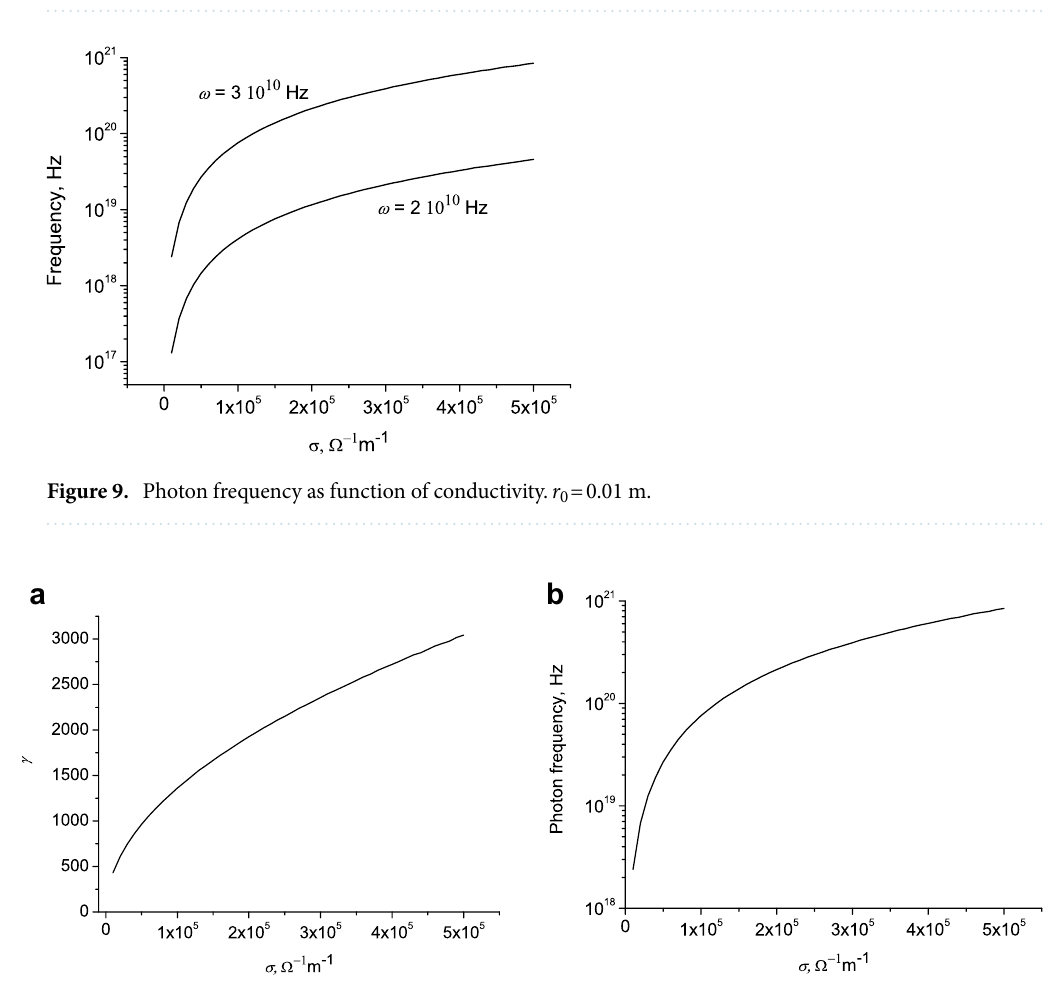
Figure 10. The Lorentz factor ( a ) and photon frequency ( b ) as function of conductivity. ω Hz, r 0 = 0.01